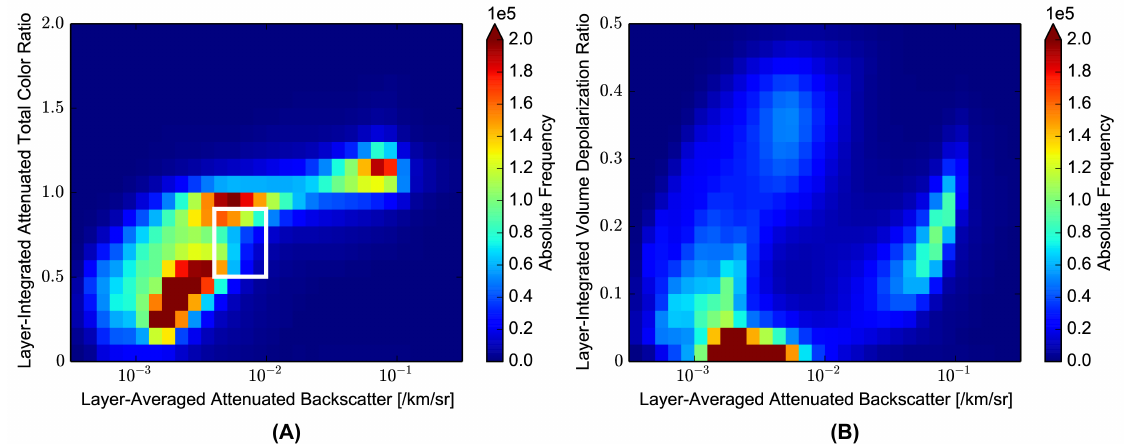
Figure 1. Occurrence frequencies of cloud and aerosol features in the 2D space of dimensions color ratio (CR), attenuated backscatter (AB) and depolarization ratio (DR). CR-AB includes aerosol (lower left) and cloud (upper right) clusters. The expected overlap region is marked by a white box ( A ); the DR-AB space includes three clusters: lower left for aerosols, upper right for ice clouds and lower right for water clouds ( B ). Table 1. Typical scattering characteristics (AB, CR, DR) of non-dust aerosols, water and ice clouds measured by the Cloud-Aerosol LIdar with Orthogonal Polarization